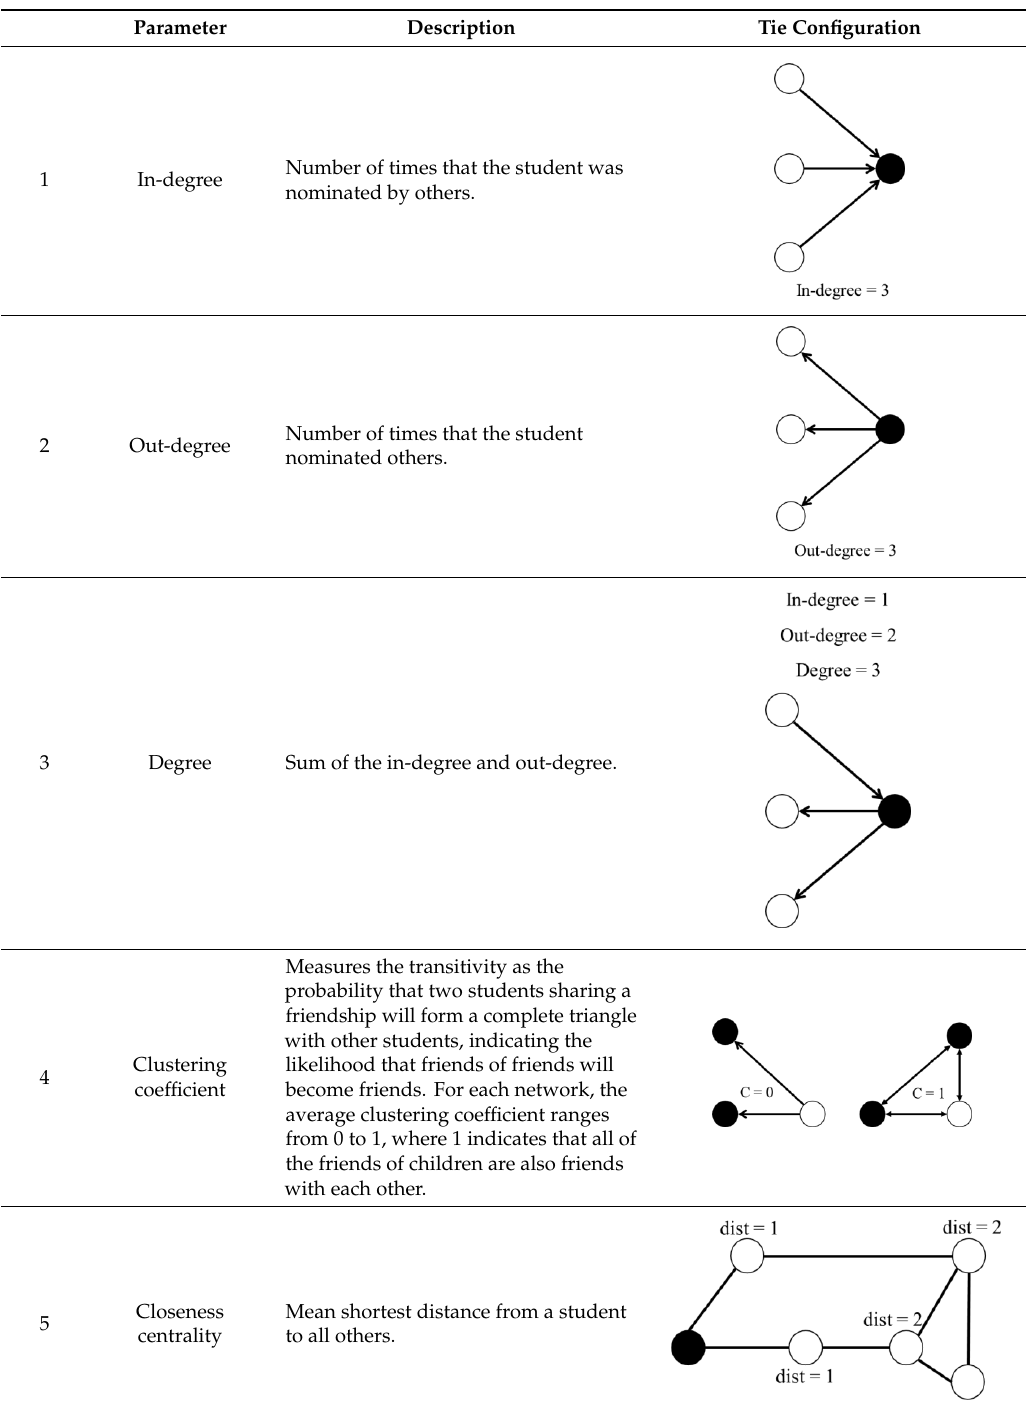
Table 1. Network structure variables and their description.